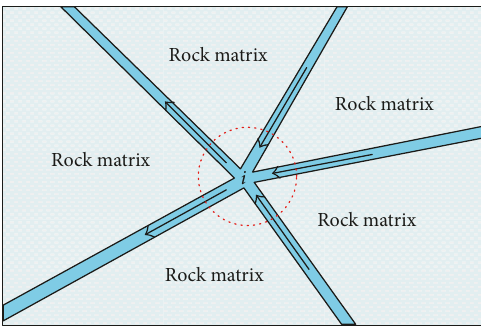
Figure 2: Local coordinates of the fracture 𝑖𝑗 .